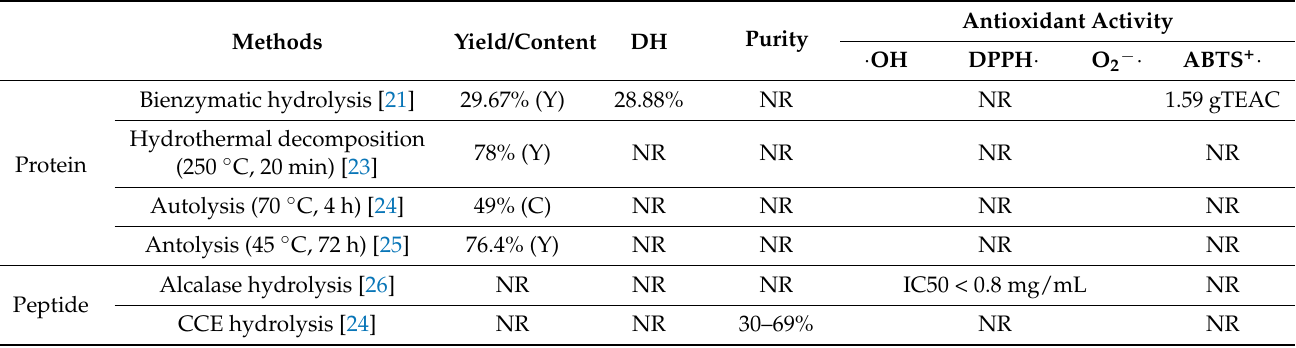
Table 1. Extracting protein and polypeptide from